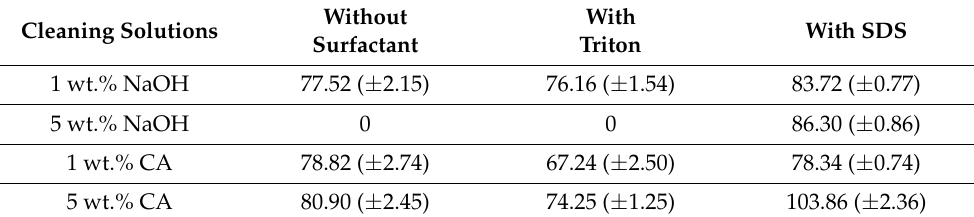
Table 9. Contact angle of membranes after applying chemical agents. Without Cleaning Solutions Surfactant